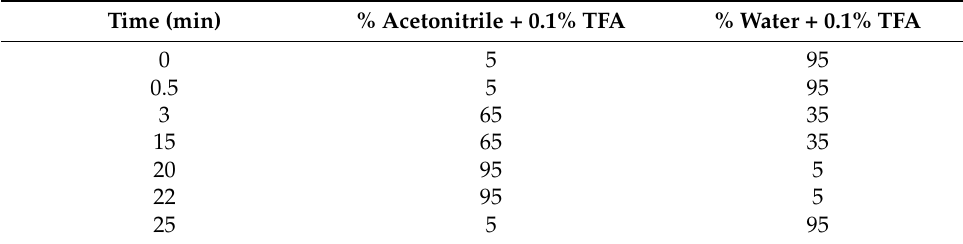
Table 3. Detailed gradient for the developed